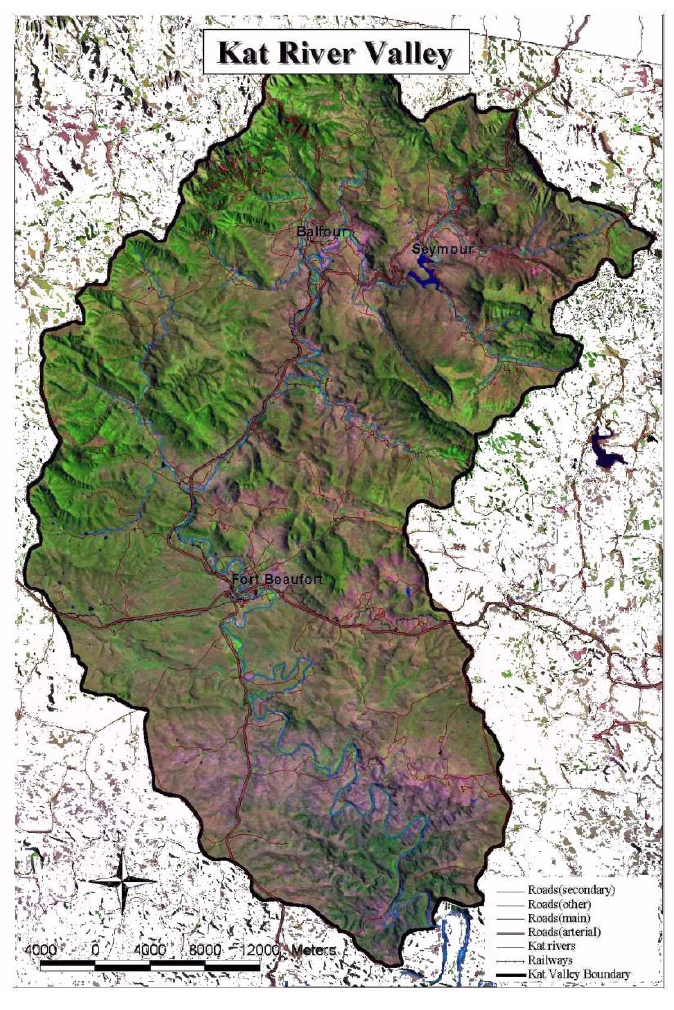
Figure 1. Kat River flowing through the Kat River